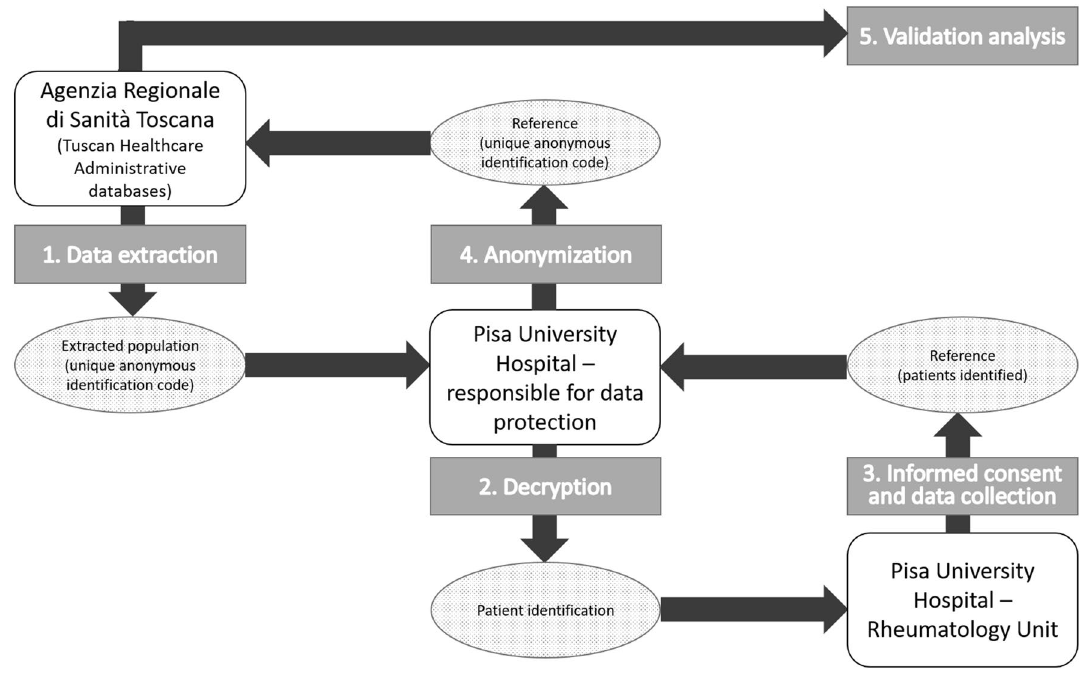
Figure 1. Validation dataflow. 1. The Agenzia Regionale di Sanità Toscana selected from Tuscan Healthcare Administrative databases (THAD) the extracted population through the unique anonymous identification code (UAIC). 2. The list of codes were sent to the responsible for data protection of the Pisa University Hospital for the decryption process of patient codes that consists in associating the corresponding internal ID code. 3. The investigators of the Rheumatology Unit of the Pisa University Hospital acquire the informed consent of the identified patients and collect the clinical data of interest from their medical charts (reference). 4. The reference sample is anonymized again with the UAIC and data collected from medical charts has been linked to data recorded in the THAD. 5. Finally, the validation analysis was admission or assignment of a co-payment exemption code in which the assumed diagnosis of RA was recorded, whichever came first, was used as the date of the assumed diagnosis. We tested the performance of four algorithms in the identification of true positive patients (i.e. patients with assumed RA diagnosis according to index test that were actual RA patients according to the reference) and true negative patients (i.e. patients with assumed non-RA diagnosis according to index test that were actually non- RA patients according to reference). Out of patients with the first supply of bDMARD from 2014 to 2016 and at least one visit at the Rheumatology Unit of Pisa University Hospital from 2013 to the index date, we tested the performance of the following four index tests (algorithms): (1) RA according to hospital discharge records or emergency department admissions (ICD-9 code, 714*); (2) RA according to exemption code from co-payment (006); (3) RA according to hospital discharge records or emergency department admissions (ICD-9 code, 714*) AND RA according to exemption code from co-payment (006); 4) RA according to hospital discharge records or emergency department admissions (ICD-9 code, 714*) OR RA according to exemption code from co-payment (006) (Supplementary Material, SM Fig. 1).